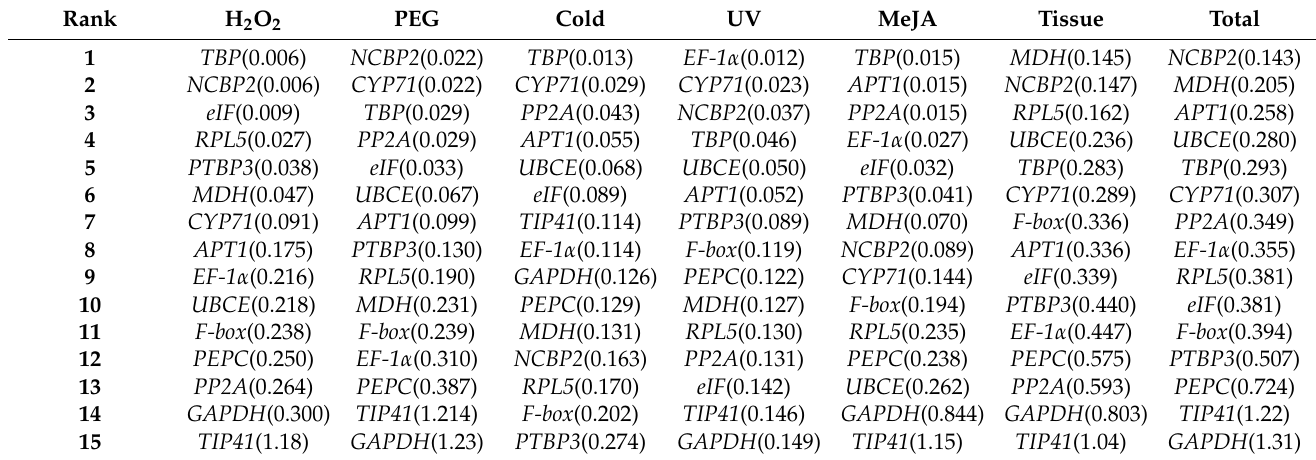
Table 2. Expression stability rank of 15 candidate reference genes by